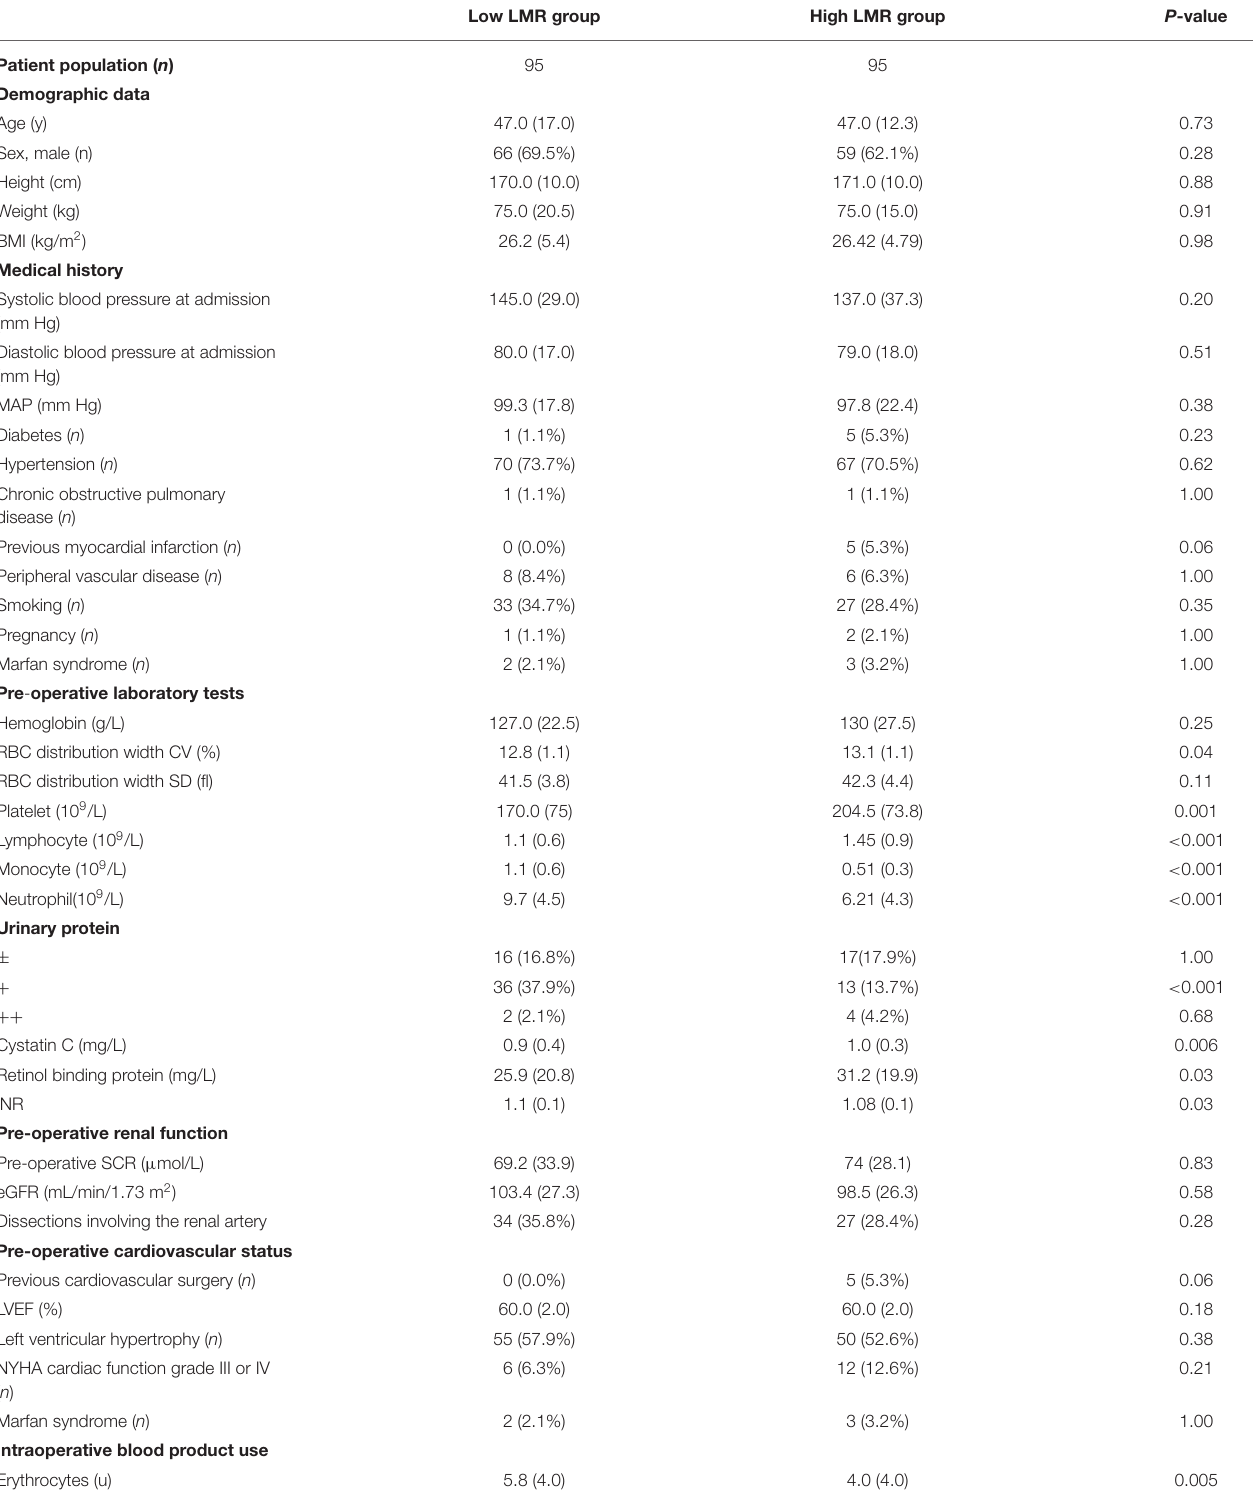
TABLE 2 | Clinical characteristics of patients with ADIAD classified by